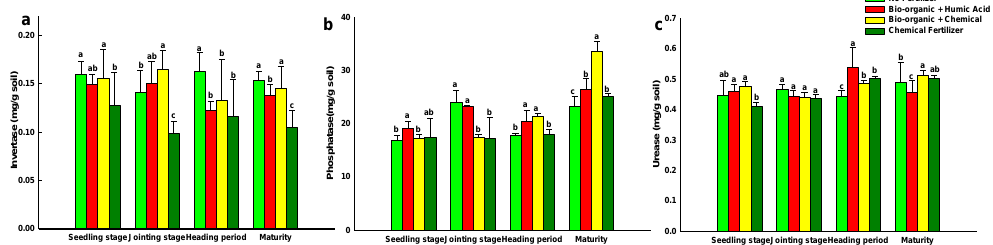
Figure 2. The impact of fertilization methods on soil enzyme activity at four maize growth stages: ( a ) Invertase, ( b ) Phosphatase, and ( c ) Urease. Values are mean and standard deviation (±SD, n = 3), and different letters correspond to significantly different values as determined via one-way ANOVA ( p < 0.05).